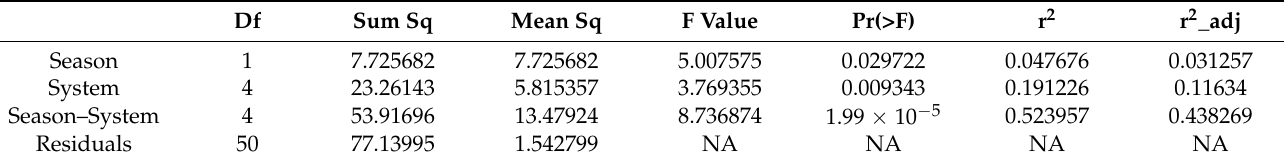
Table A10. Total soluble solid content.